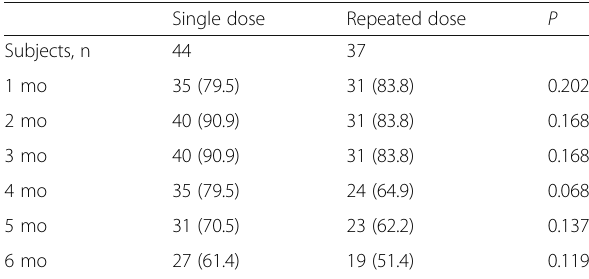
Table 3 Response to treatment at follow-ups throughout the study, n (%)